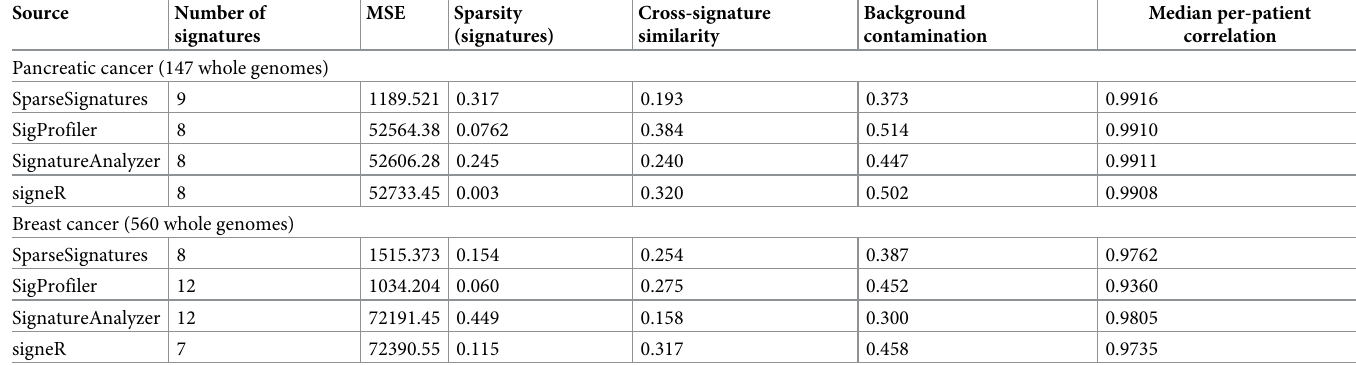
Table 2. Comparison of signatures predicted by four signature discovery methods on real tumor sequencing data. Sparsity is measured as the fraction of cells in the signature matrix with value < 10 − 4 . Cross-signature similarity is measured as the mean cosine similarity between all pairs of predicted signatures. Background contamina- tion is measured as the mean cosine similarity between the background signature and all non-background predicted signatures. Median per-patient correlation is mea- sured as the median Pearson’s correlation coefficient between the observed mutation spectrum and the predicted mutation spectrum for each patient, indicating how well each method fits the observed mutations in individual